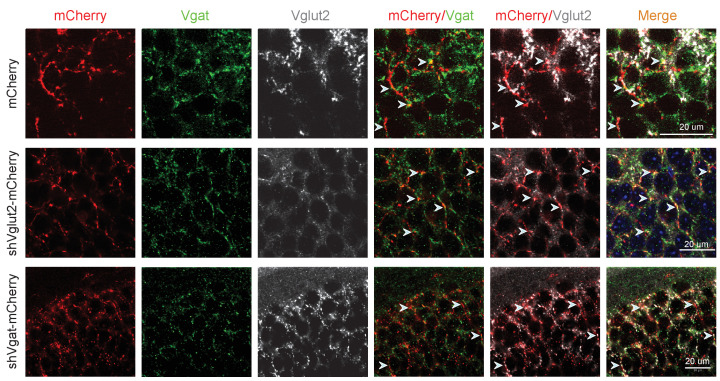
Genetic knockdown of Vgat and Vglut2 in SuMVgat neurons.Immunohistochemical staining of Vgat or Vglut2 in DG synaptic terminals emanating from SuMVgat neurons. After shVgat and shVglut2 expression in the SuM, Vgat and Vglut2 expression from SuMVgat-DG projections was virtually absent in DG mCherry+ terminals (white arrow heads). Scale bar = 20 µm.